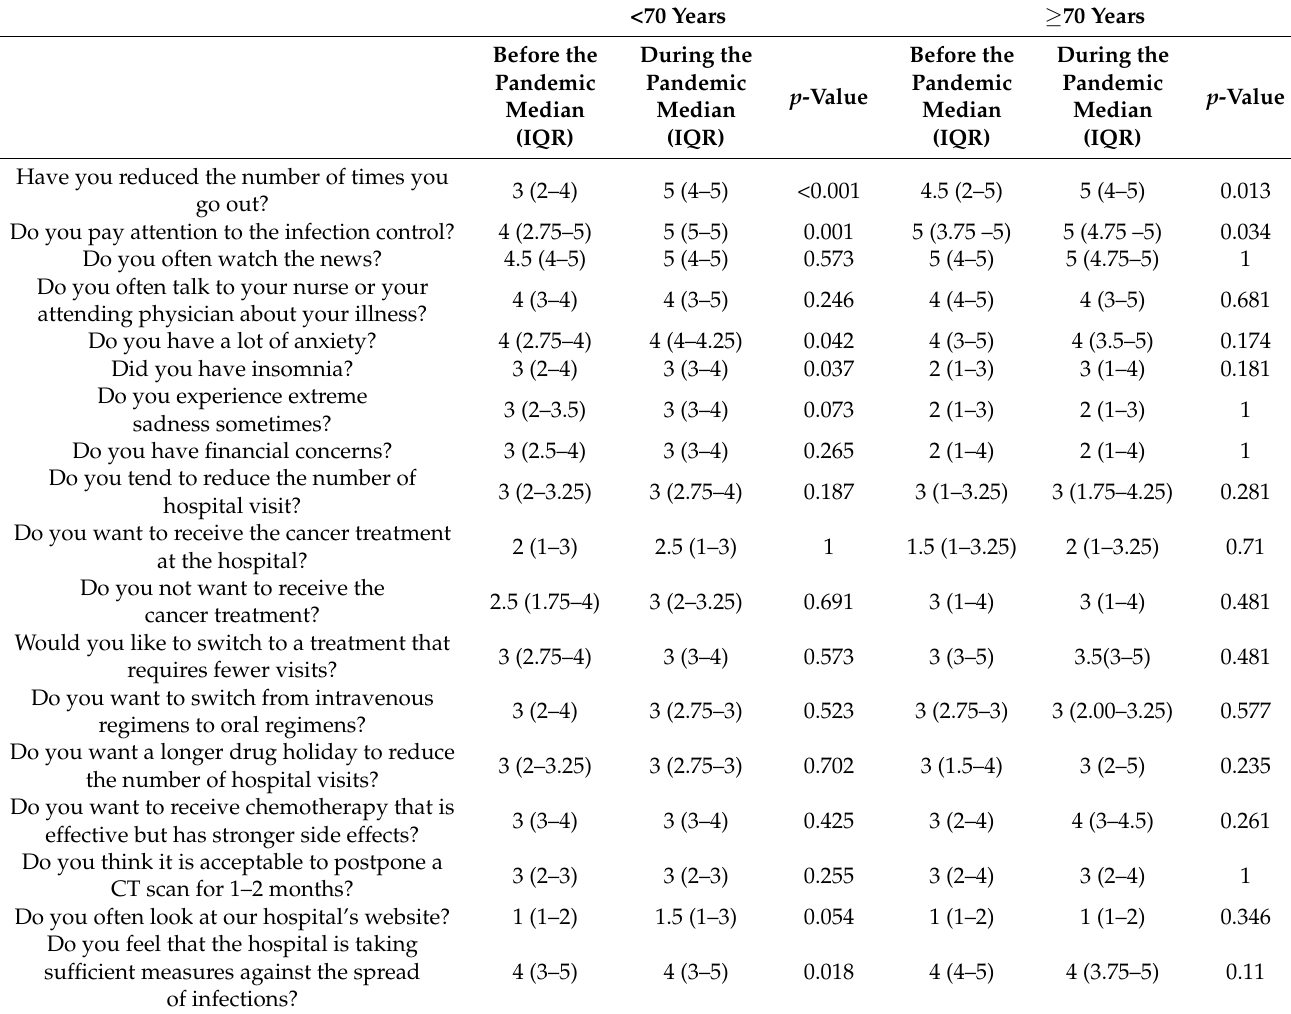
Table 3. The distribution of the responses by age (<70 years or >70 years) to the